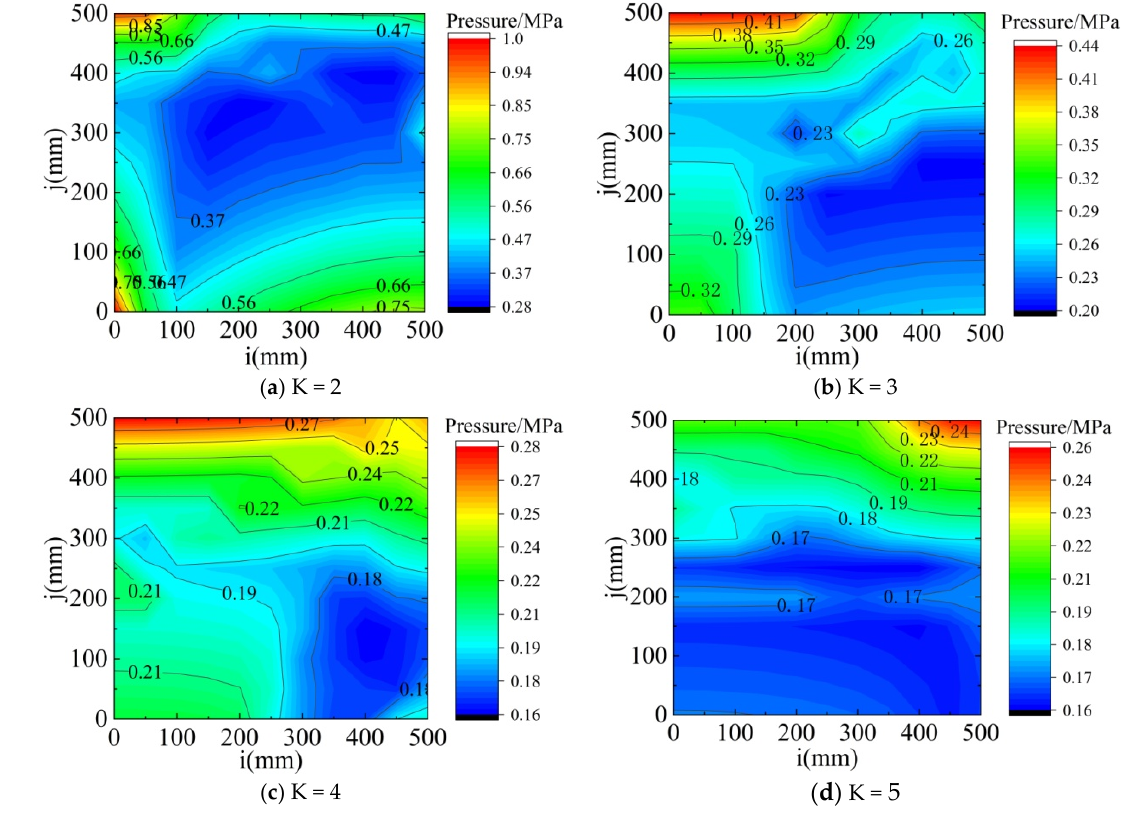
Figure 13. Pressure contour distribution diagram in the corner area .